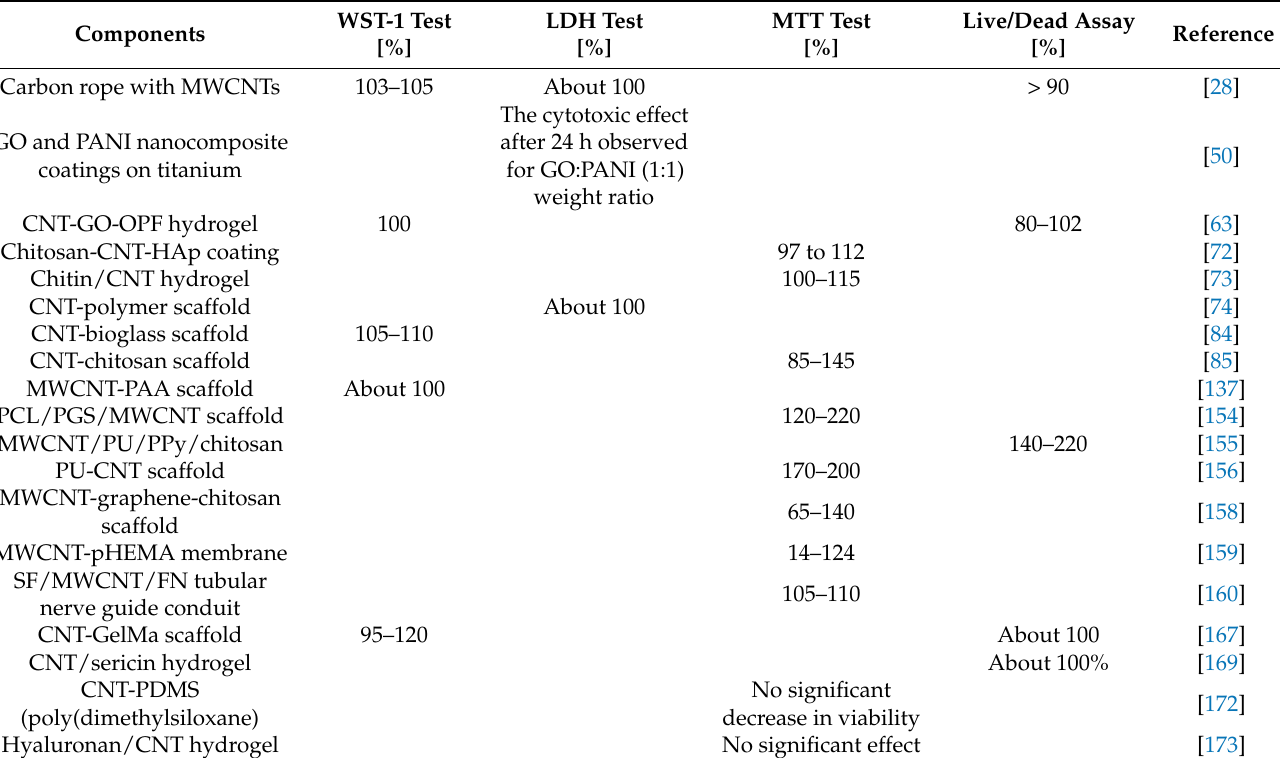
Table 2. Biological properties of CNT-implemented coatings and